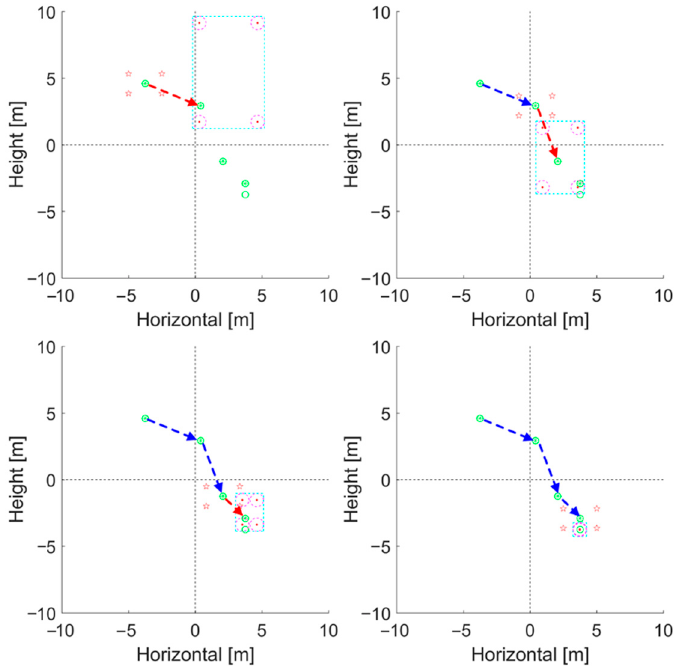
Figure 7. The simulated result of searching for a trapped person along a searching path. Table 2. The simulated result for the vital sign searching path. Table 2. The simulated result for the vital sign searching